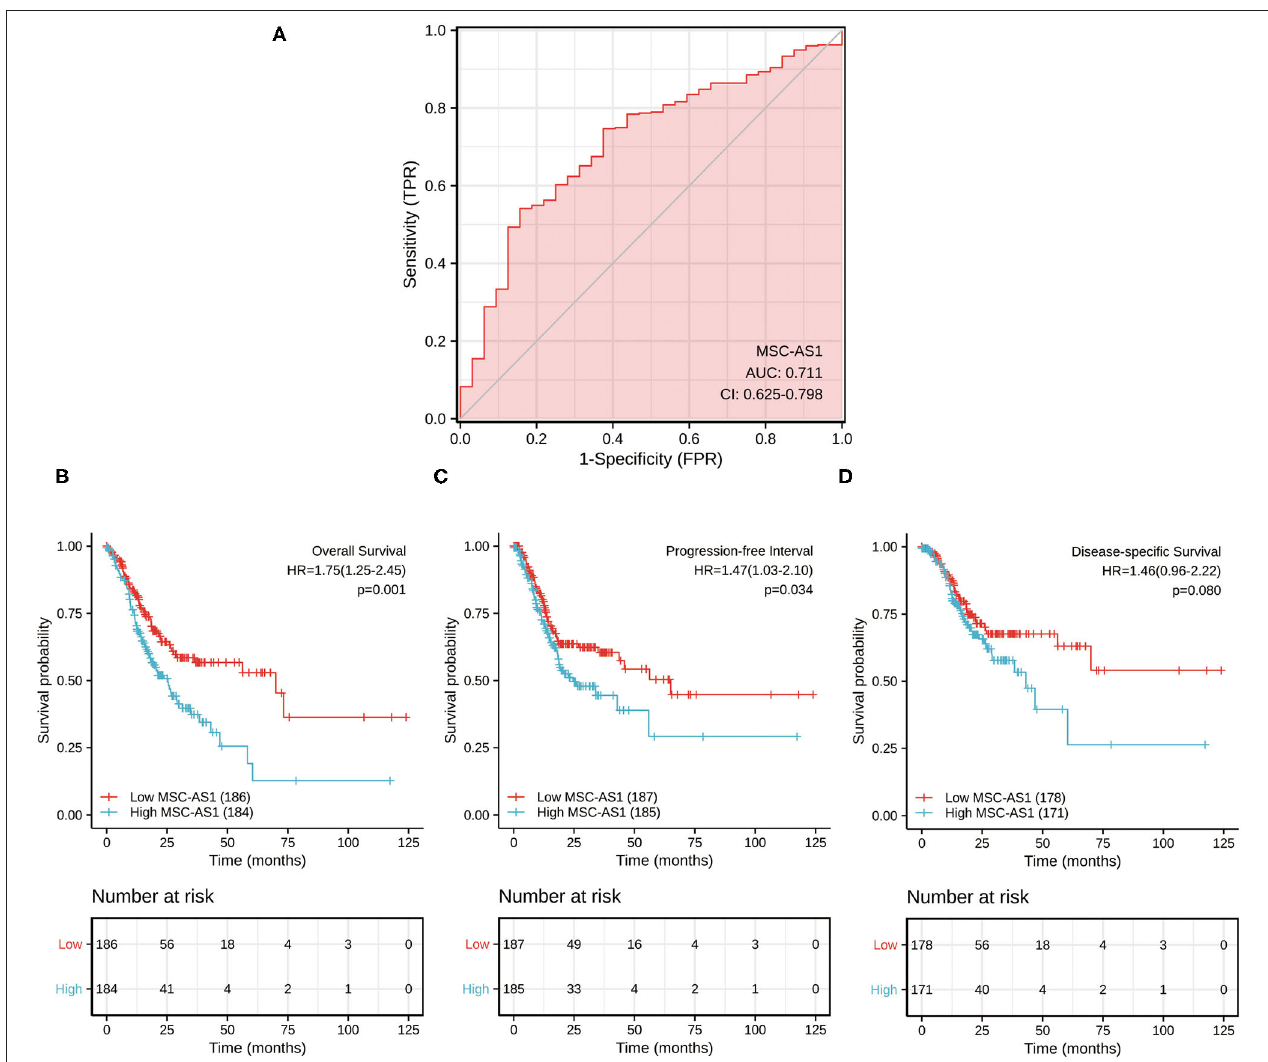
FIGURE 5 | (A) Receiver operating characteristic (ROC) analysis of long non-coding RNA (lncRNA) MSC-AS1 expression showing promising discrimination power between non-tumor and tumor tissues. The area under the curve (AUC) is plotted as sensitivity (%) vs. 100% specificity. Impact of long non-coding RNA (lncRNA) MSC-AS1 expression on (B) overall survival, (C) progression-free interval, and (D) disease-specific survival in patients with gastric cancer in The Cancer Genome Atlas (TCGA)